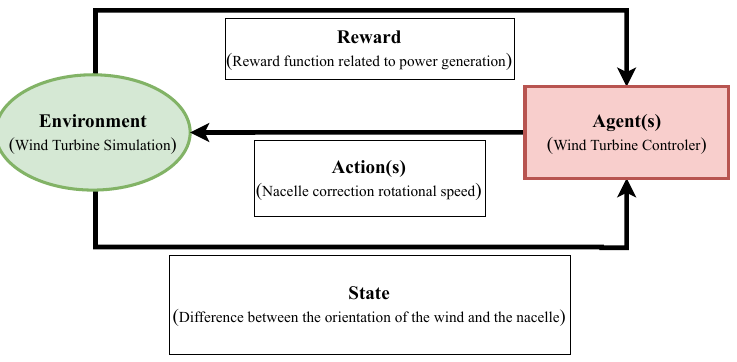
Figure 9. Basic RL mechanism for wind farm control.